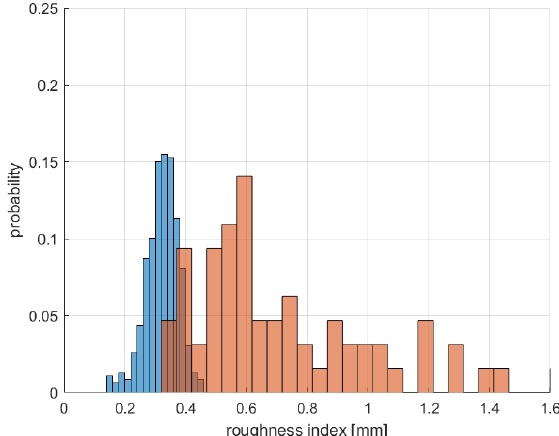
Figure 9. Comparison of roughness index distributions for bricks in good conditions (blue) and damaged ones